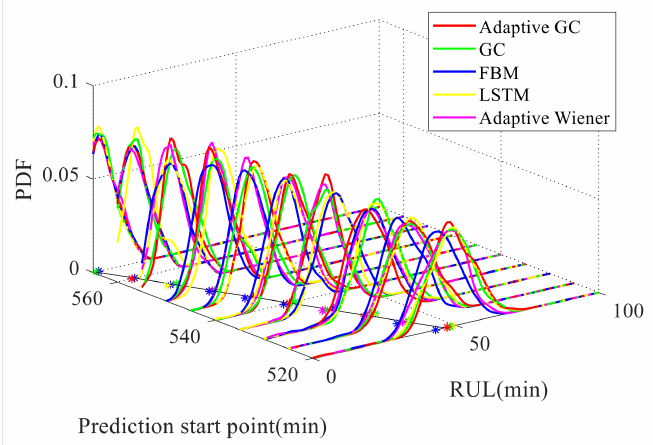
Figure 15. The PDFs of the RUL of different prediction models. In Figure 15, the black straight line represents the actual RUL, and the five-colored star represents the estimated RUL. The RUL obtained by the five different prediction models is expressed in a two-dimensional plane, and the results are shown in Figure 16. The estimated RUL value of the different models are shown in Table 5.